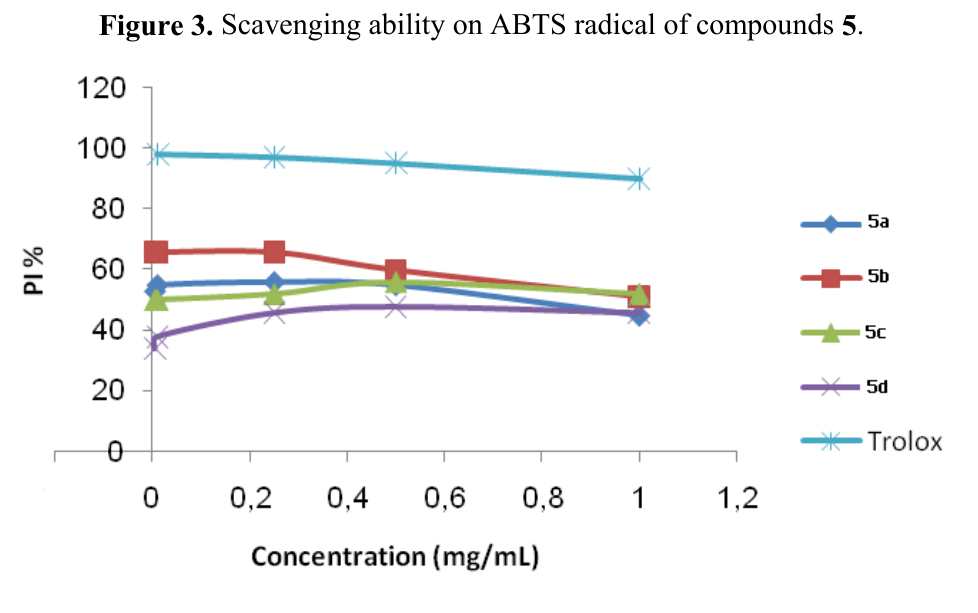
Table 5. Values of IC50 exhibited by coumarinic derivatives 5a – d .